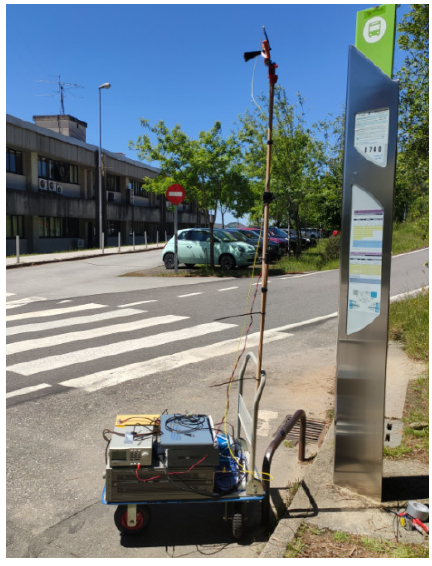
Figure 1. Transmitter configuration.